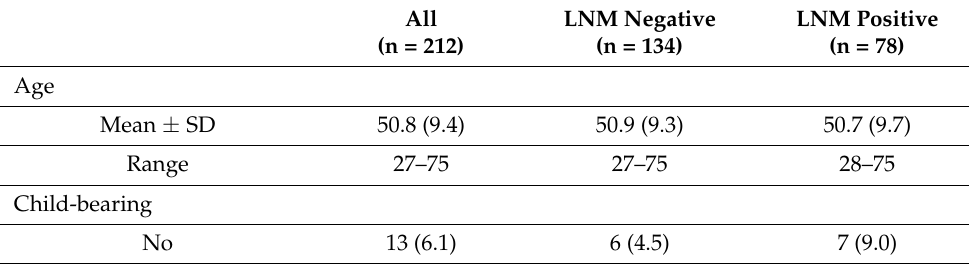
Table 1. Baseline characteristics of the patients included in this